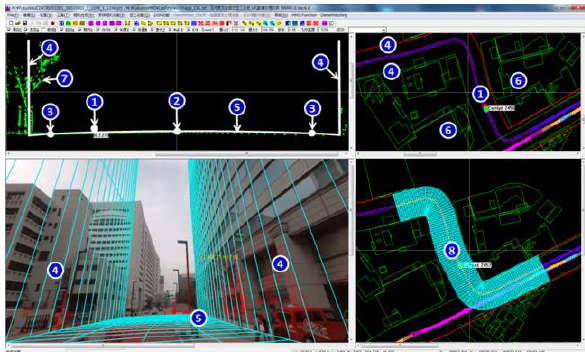
Figure 5. Interface of 3D mesh data generation for our MMS data processing system (left-up view: cross section of the 3D mesh data, which can be switched into stereo measurement mode with stereo 360° panoramic images and aerial images; right-up view: MMS trajectory on 2D map, which can be switched into ground ortho-image and single aerial image mode; left-down view: 3D view for overlapped MMS laser point cloud and 360° panoramic image; right-down view: hybrid measurement by laser point cloud and 360° panoramic images), where the labelled number ① denotes MMS position; ② denotes the road center; ③ denotes road curbs; ④ denotes the sides of the 3D mesh data determined by the average distance; ⑤ denotes the fitted road surface with laser point cloud; ⑥ denotes the building footprints on 2D map; ⑦ denotes the MMS laser point cloud; and ⑧ denotes the 3D